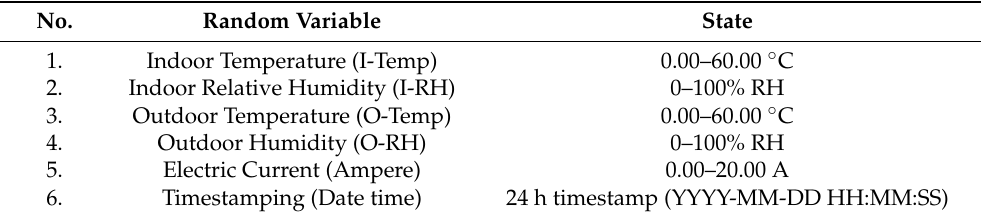
Table 1. The low-level information based on RVs for thermal comfort